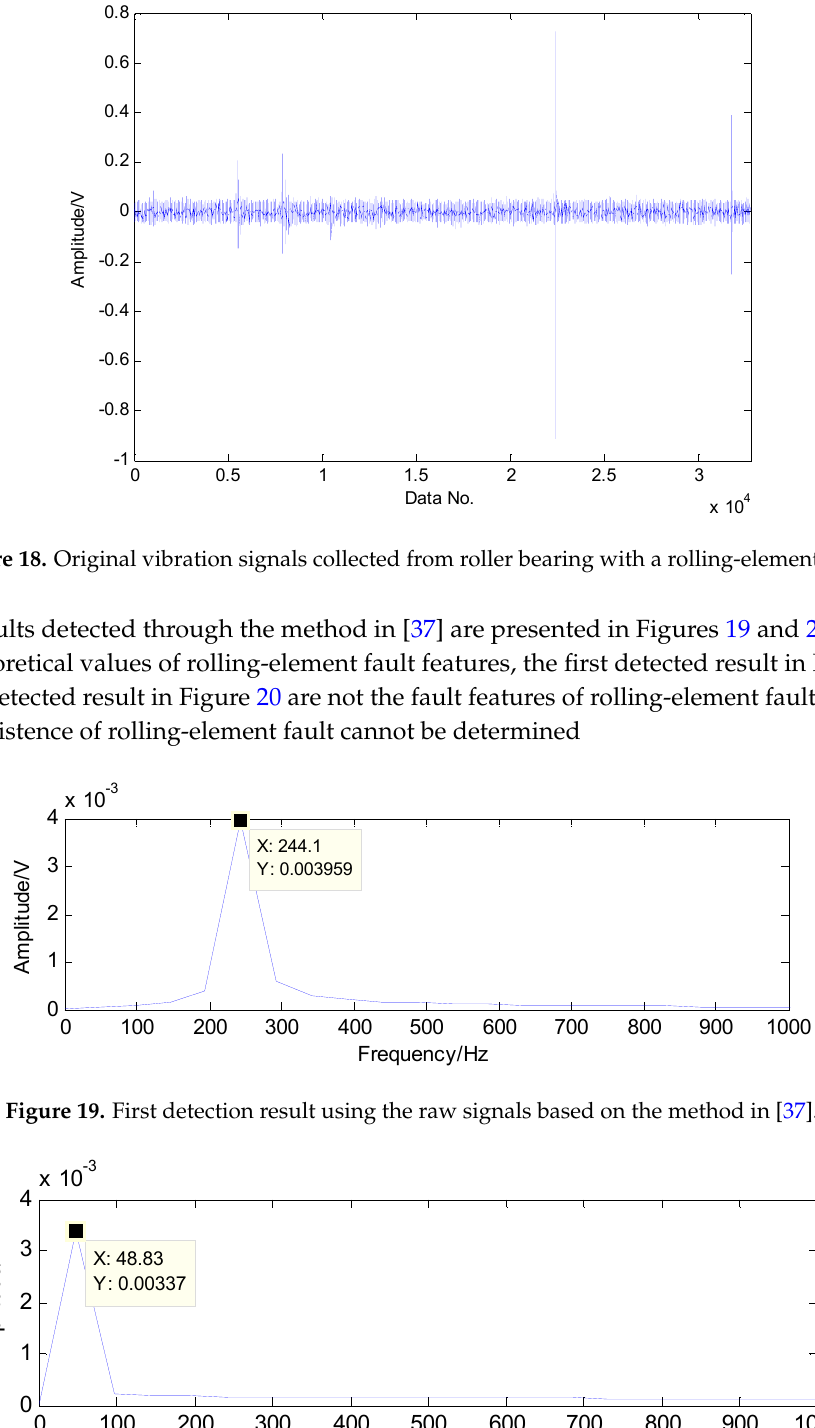
Figure 17. Second harmonic of the detected fault characteristic frequency through matching pursuit.